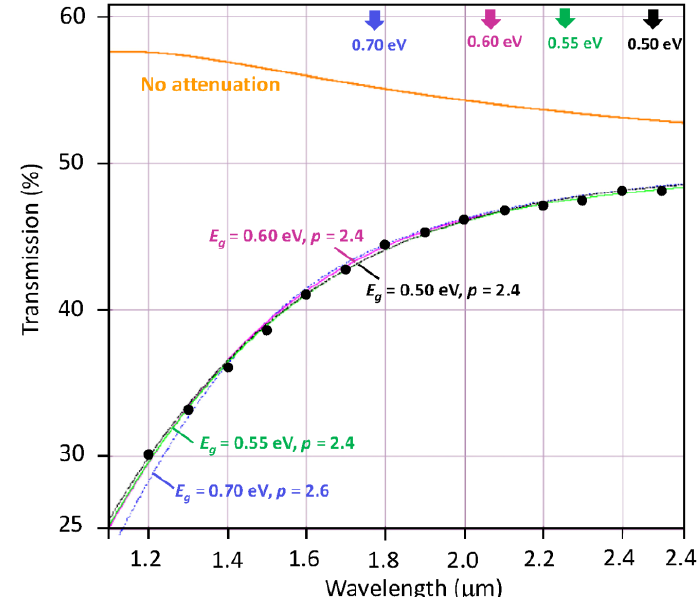
Figure 10. The transmittance vs wavelength for the 102 nm VO 2 thin film with various contributions. The orange curve is the Swanepoel transmittance with no attenuation. Other colored curves are selected fits to the data as follows: blue: E g = 0.70 eV, A a = 0.0070 nm − 1 · eV − 1 , p = 2.6, A s = 5.9 × 10 5 nm 1.6 ; magenta: E g = 0.60 eV, A a = 0.0048 nm − 1 · eV − 1 , p = 2.4, A s = 1.3 × 10 5 nm 1.4 ; green: E g = 0.55 eV, A a = 0.0038 nm − 1 · eV − 1 , p = 2.4, A s = 1.30 × 10 5 nm 1.4 ; black: E g = 0.50 eV, A a = 0.0035 nm − 1 · eV − 1 , p = 2.4, A s = 1.25 × 10 5 nm 1.4